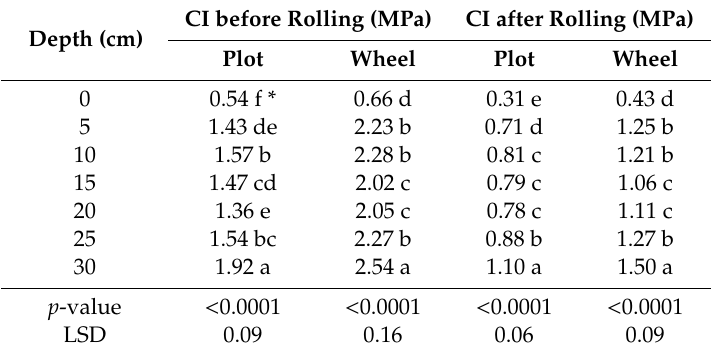
Table 16. Soil CI (cone index) for di ff erent depths (0–30 cm, with 5 cm increments) averaged over rolling treatments in 2017 growing